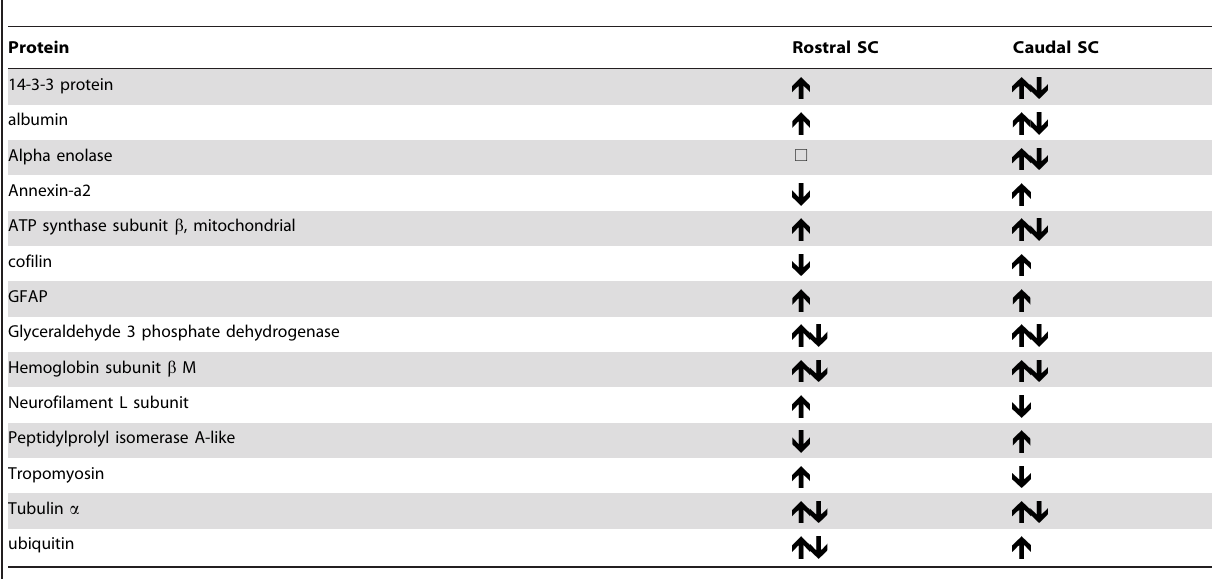
Table 7. Proteins that changed level 24 h following spinal cord injury at P28.in Monodelphis in segments rostral and caudal to site of